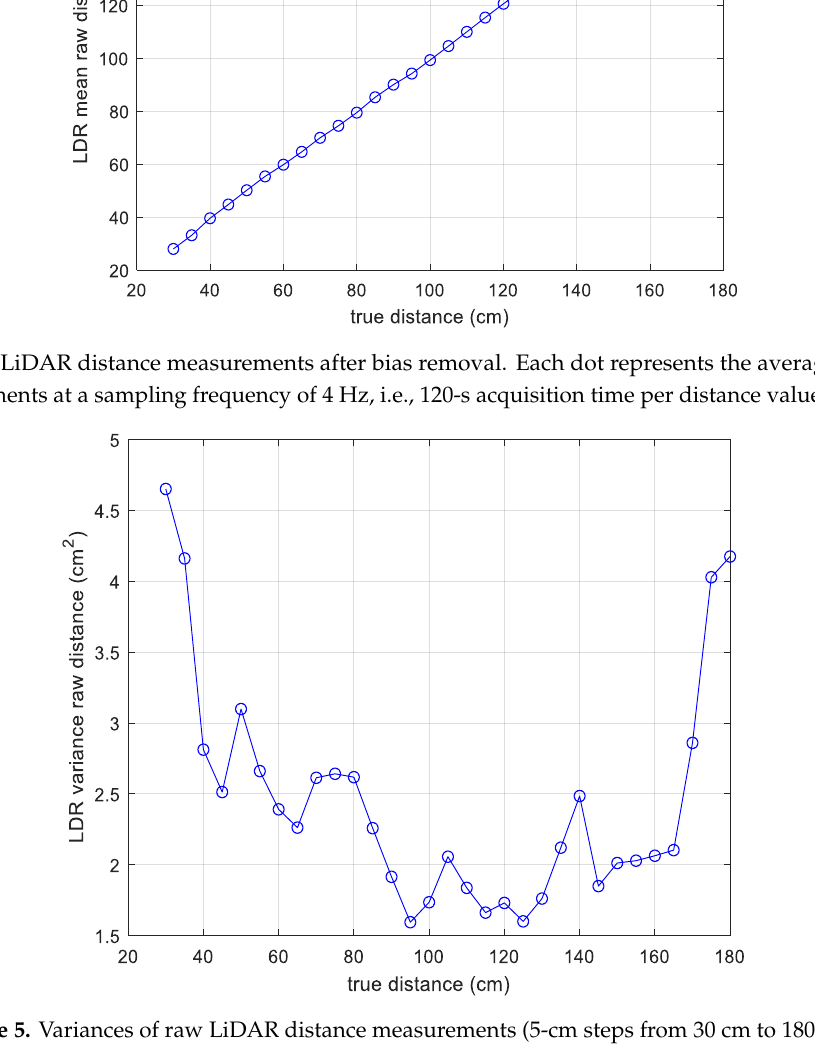
Figure 5. Variances of raw LiDAR distance measurements (5-cm steps from 30 cm to 180 cm).